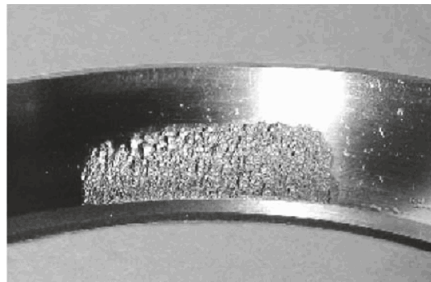
Figure 3: Outer race defect of set number 2.